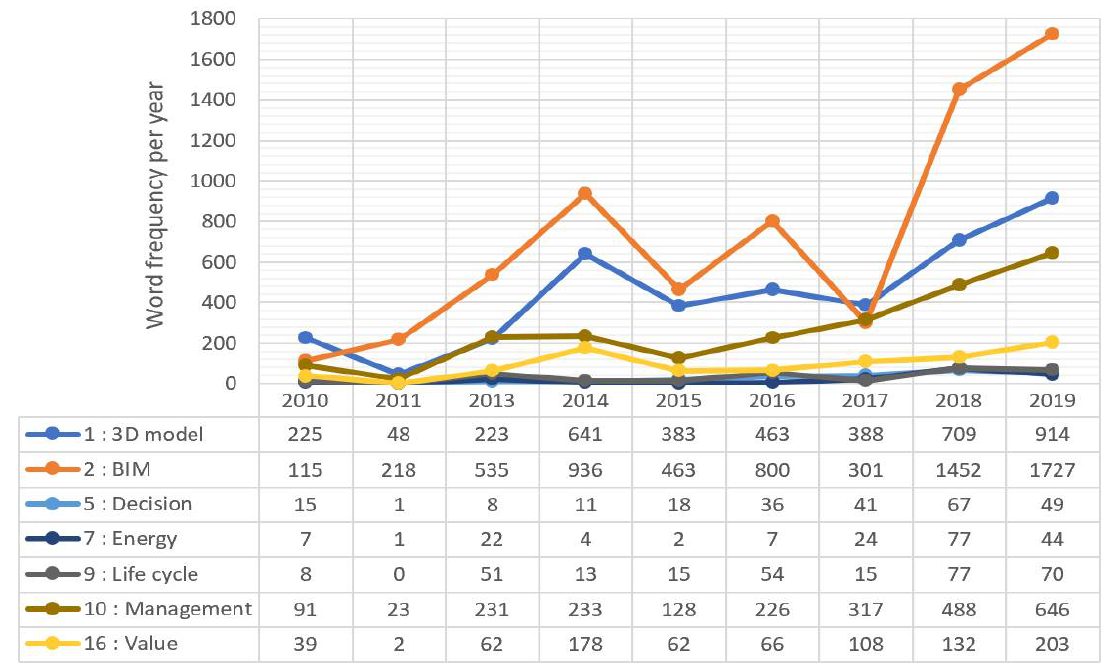
Figure 8. Key themes in four clusters of the CCM, including keyword analysis of BIM, cost-effectiveness, measuring, quantity surveying, and scheduling.